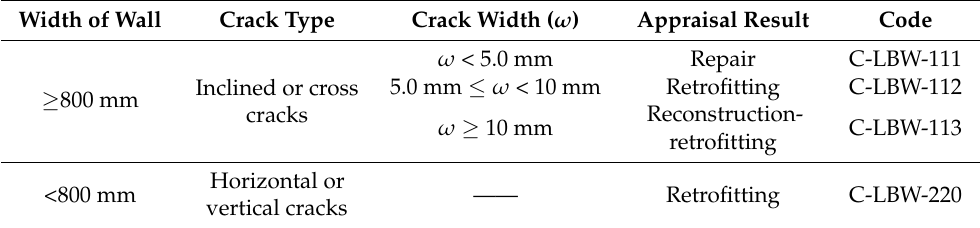
Table 3. Coding guidelines for wall cracks in load bearing